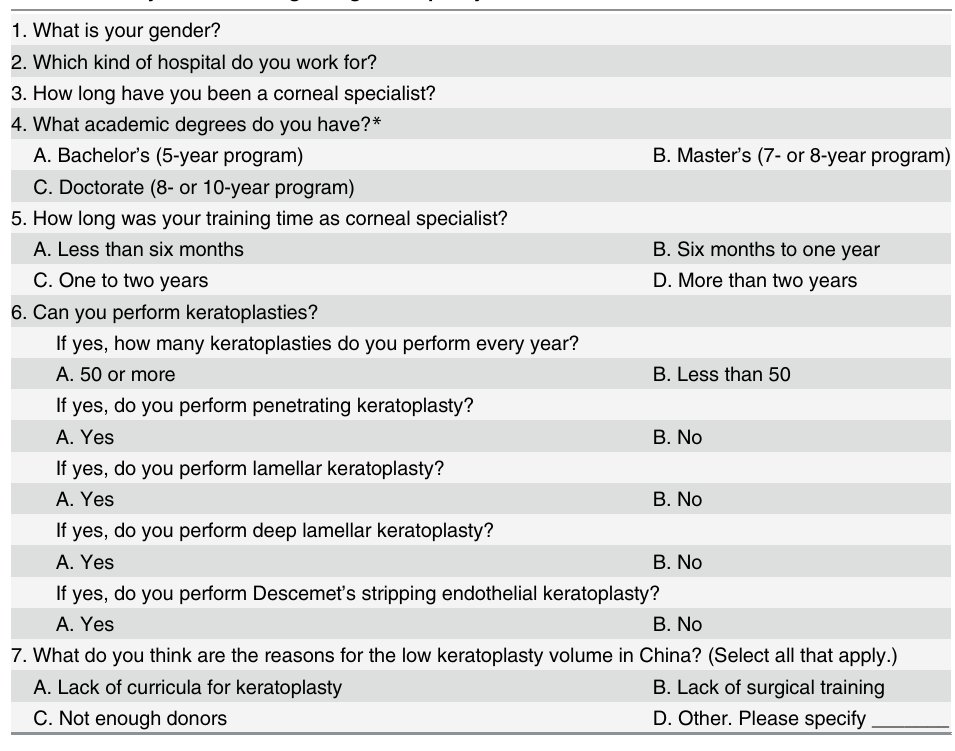
Table 1. Survey Questions Regarding Keratoplasty Practice in